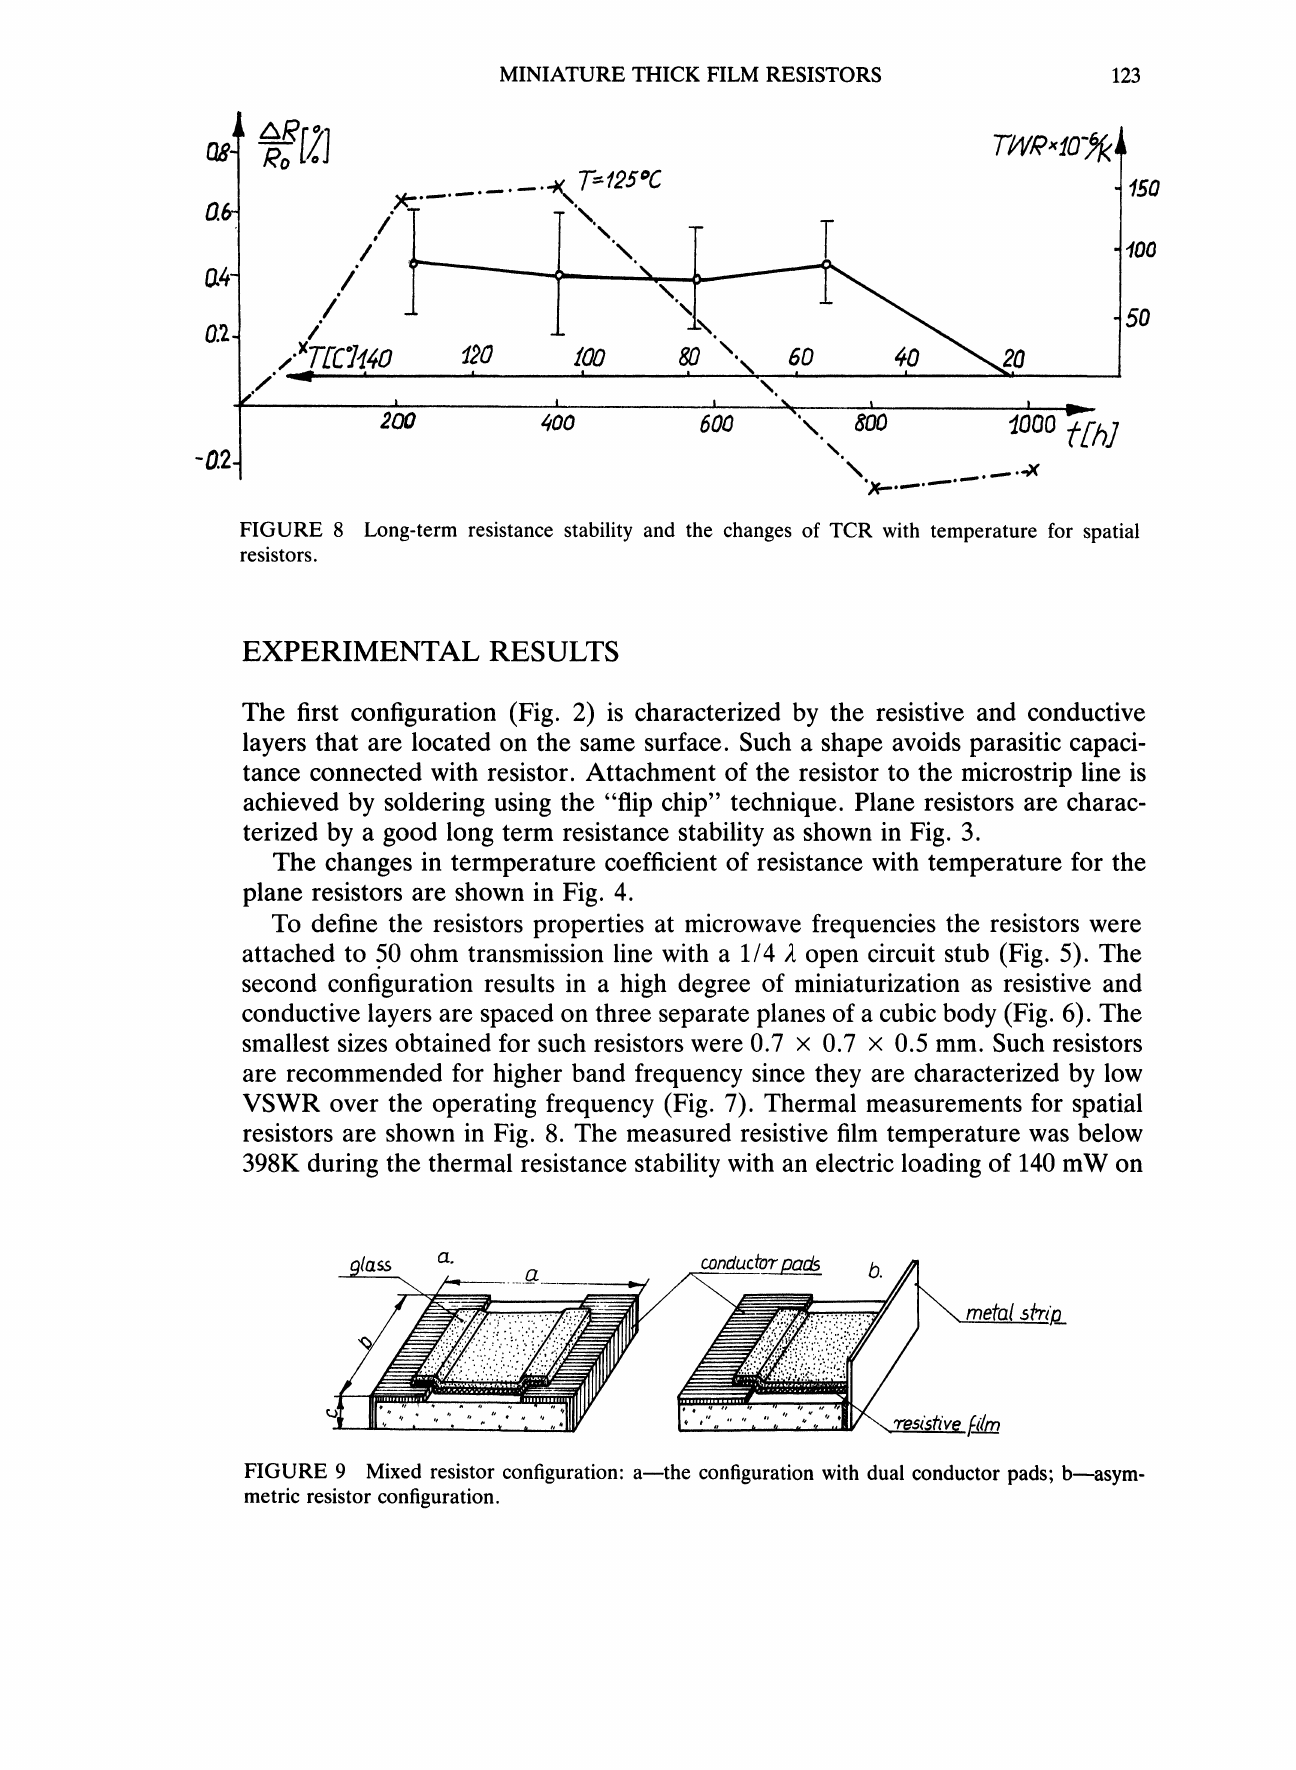
FIGURE 9 Mixed resistor configuration" amthe configuration with dual conductor pads; b--asym- metric resistor